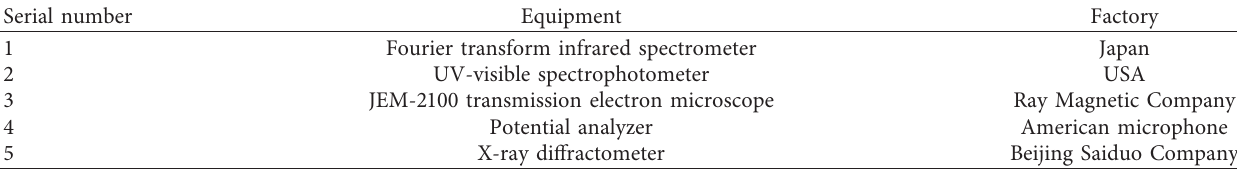
Table 1: Experimental